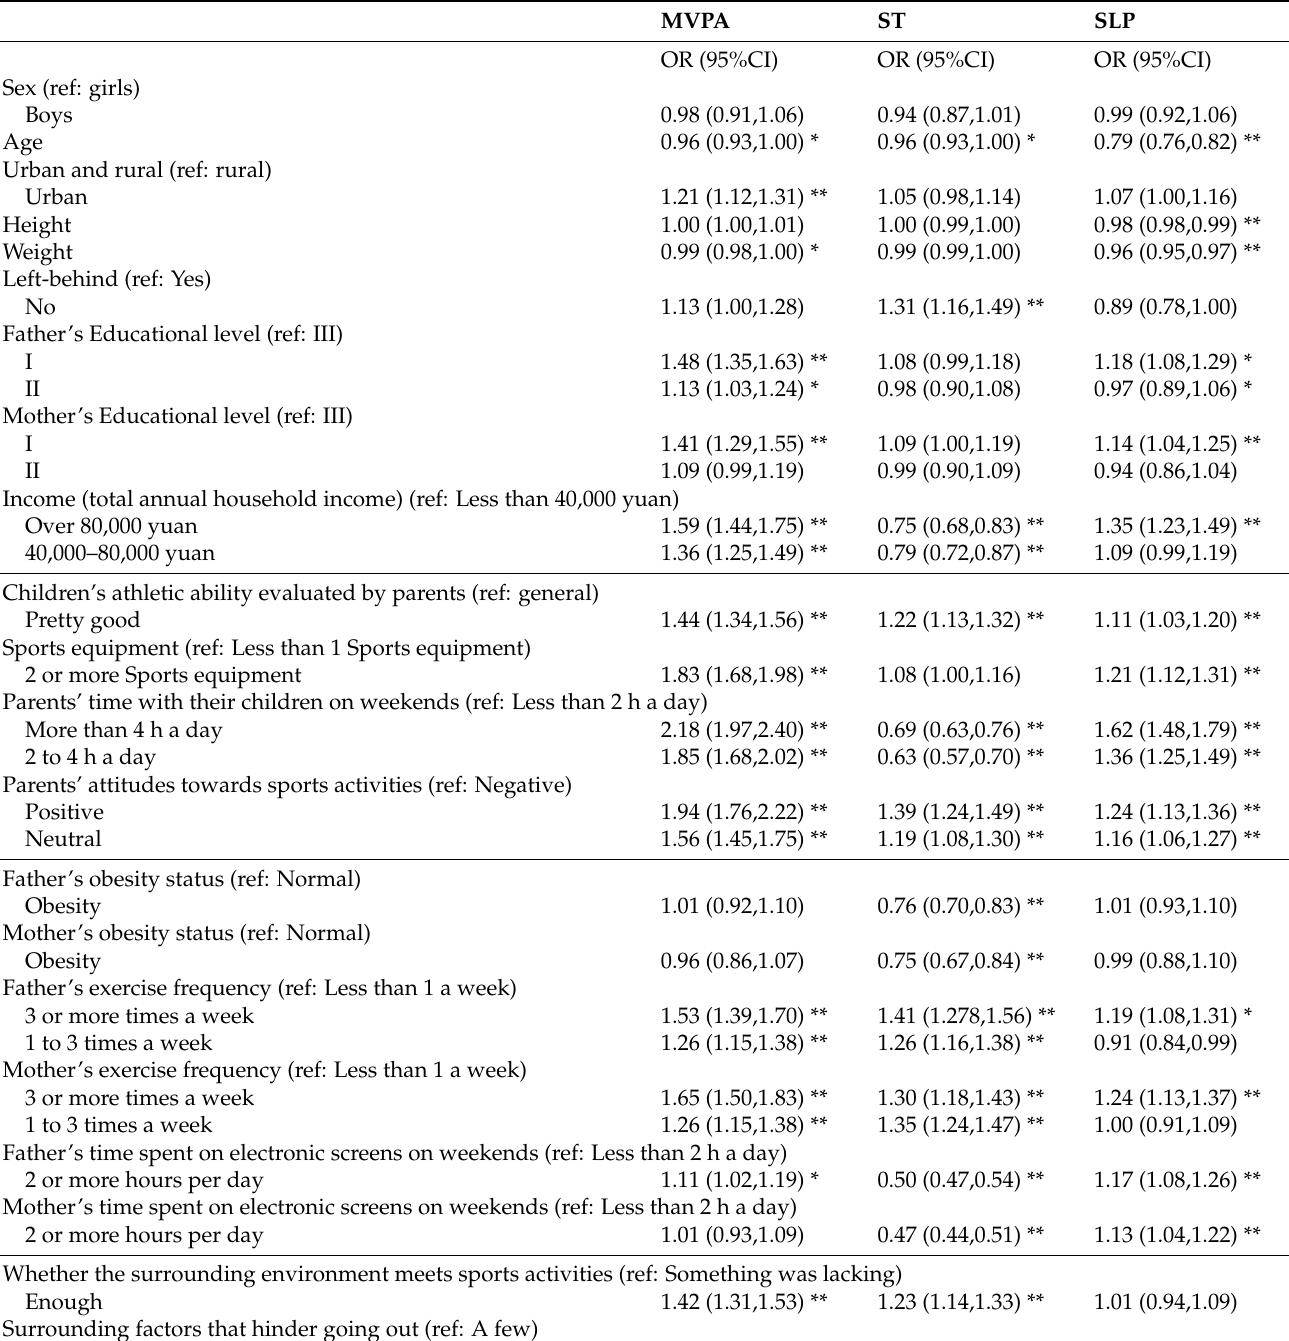
Table 3. The independent influencing factors of three health-related behaviors of children.